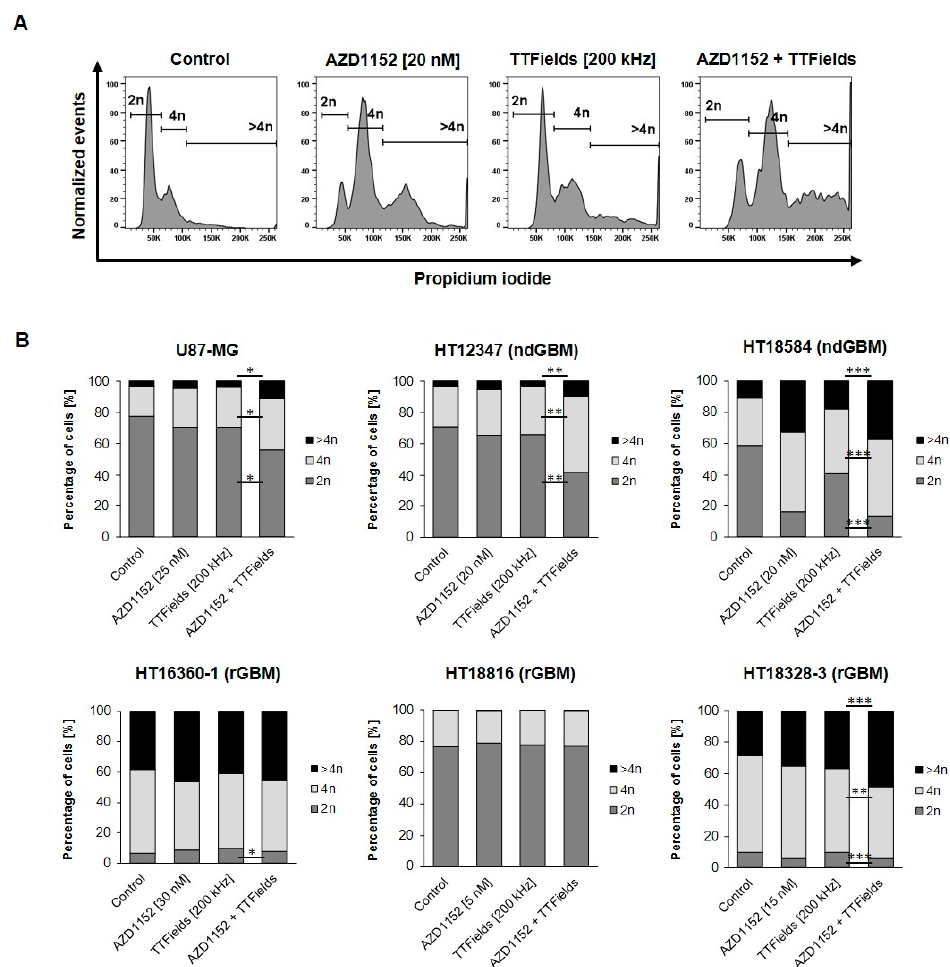
Figure 5. Effect on ploidy. Low concentrations of AZD1152 increase TTFields-induced polyploidy in U87-MG, ndGBMs and partially in rGBMs. Cells were treated with AZD1152 alone, TTFields alone, and AZD1152 plus TTFields for 72 h. DNA content was determined by flow cytometry using propidium iodide. ( A ) Representative flow cytometric analysis of HT18584 (ndGBM, p53mut) are shown. ( B ) Data represent mean percentage of cells with DNA content of 2n, 4n and >4n for each treatment (N ≥ 4). * p < 0.05, ** p < 0.01, *** p < 0.001.